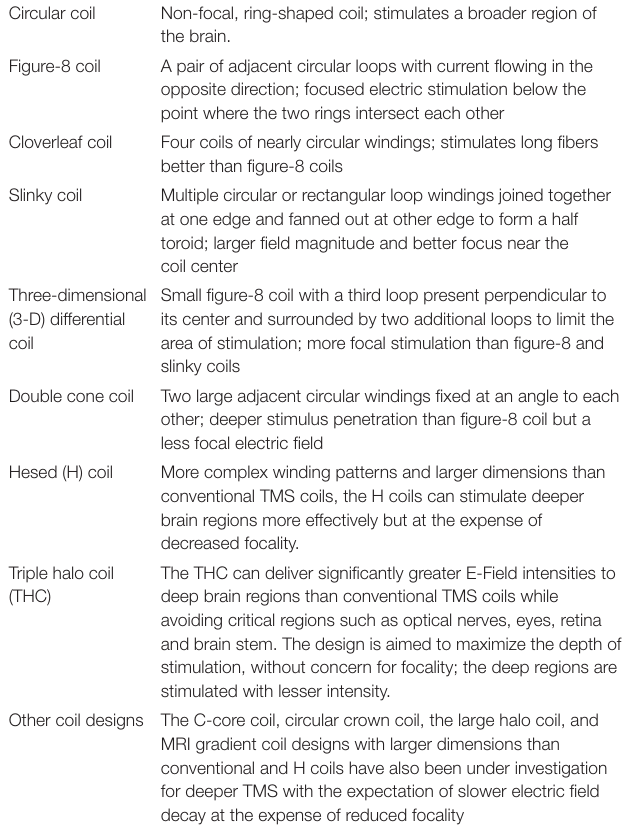
TABLE 2 | Types of coils (9–12). Circular coil Non-focal, ring-shaped coil; stimulates a broader region of the brain. Figure-8